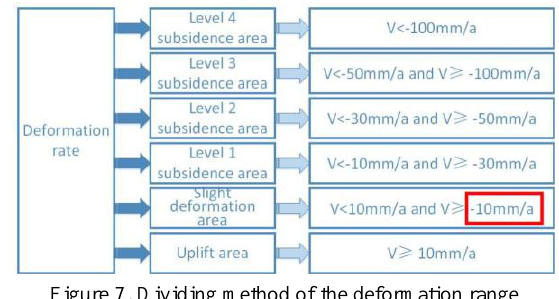
Figure 7. Dividing method of the deformation range